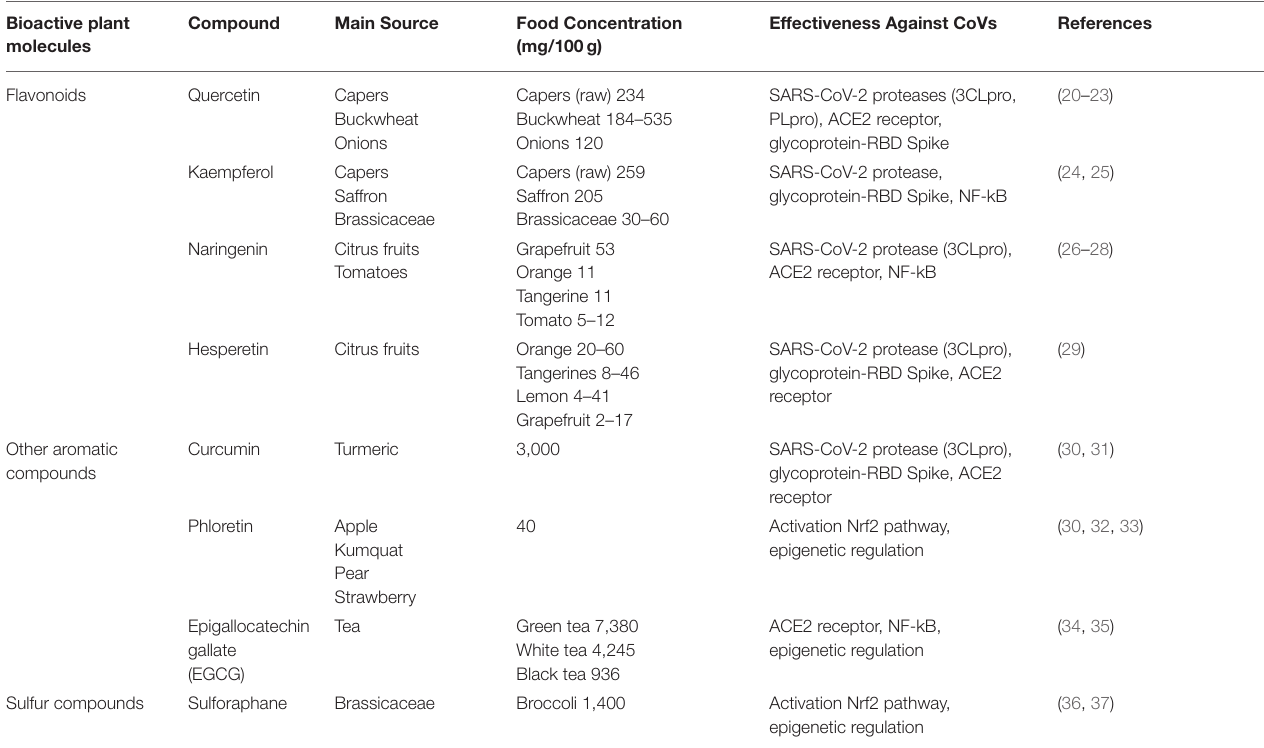
TABLE 1 | Main foods rich in bioactive molecules and their effectiveness against CoVs. Bioactive plant